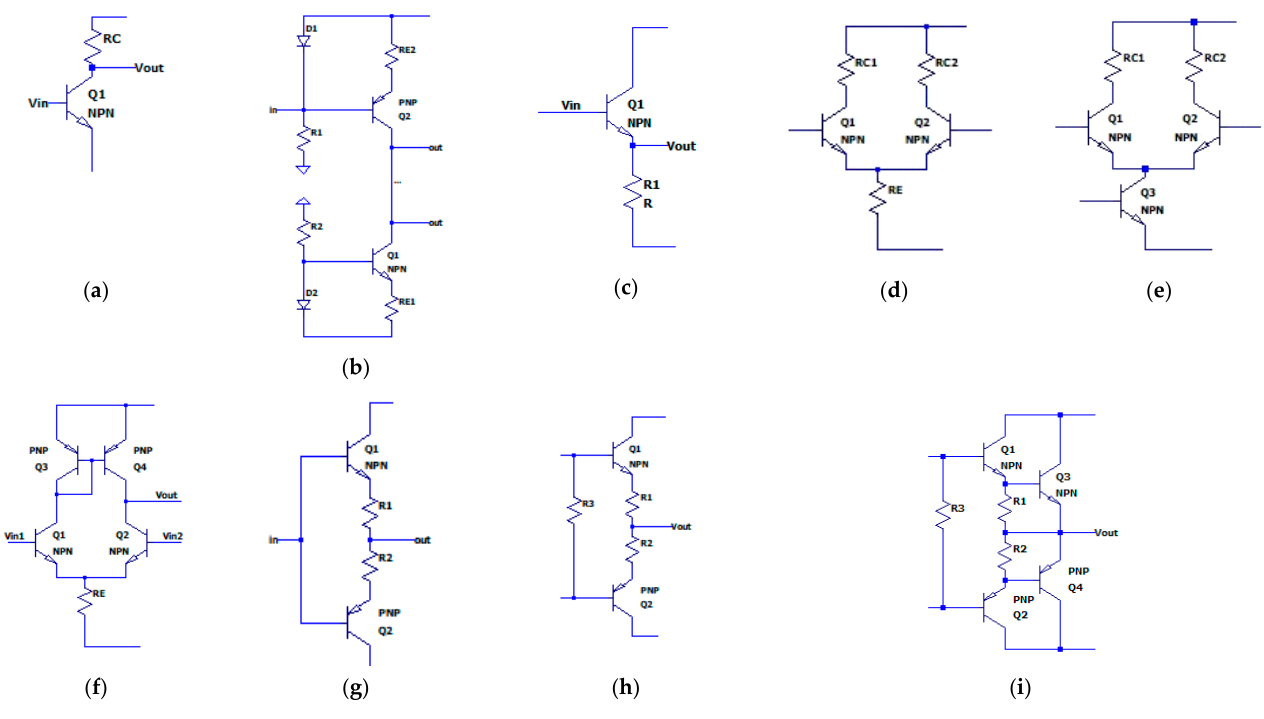
Figure 4. ( a ) Common emitter; ( b ) common emitter with active load; ( c ) common collector; ( d )